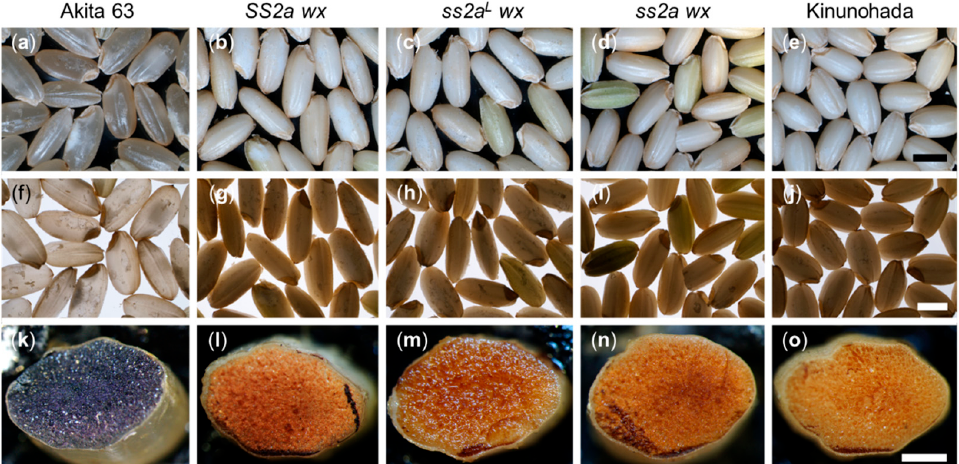
Figure 4. Morphology of rice grains and iodine staining of seed cross-sections. ( a – j ) Analysis of the morphology of dehulled rice seeds by stereomicroscopy with illumination from above ( a – e ) and below ( f – j ). Scale bars, 3 mm. ( k – o ) Cross-sections of rice seeds stained with iodine and observed under a stereomicroscope. Scale bars, 1 mm.